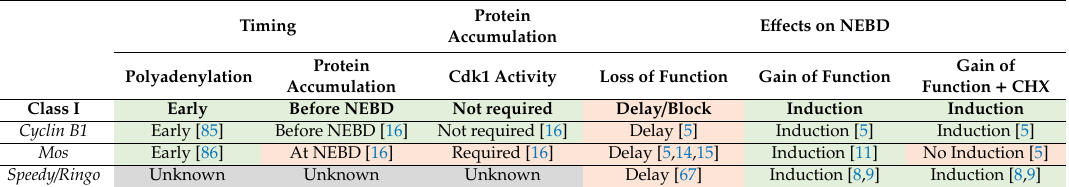
Table 4. Class I proteins whose translation is required for MPF activation in Xenopus oocytes. Summary of the expected features of the Class I proteins and those of the Class I proteins already